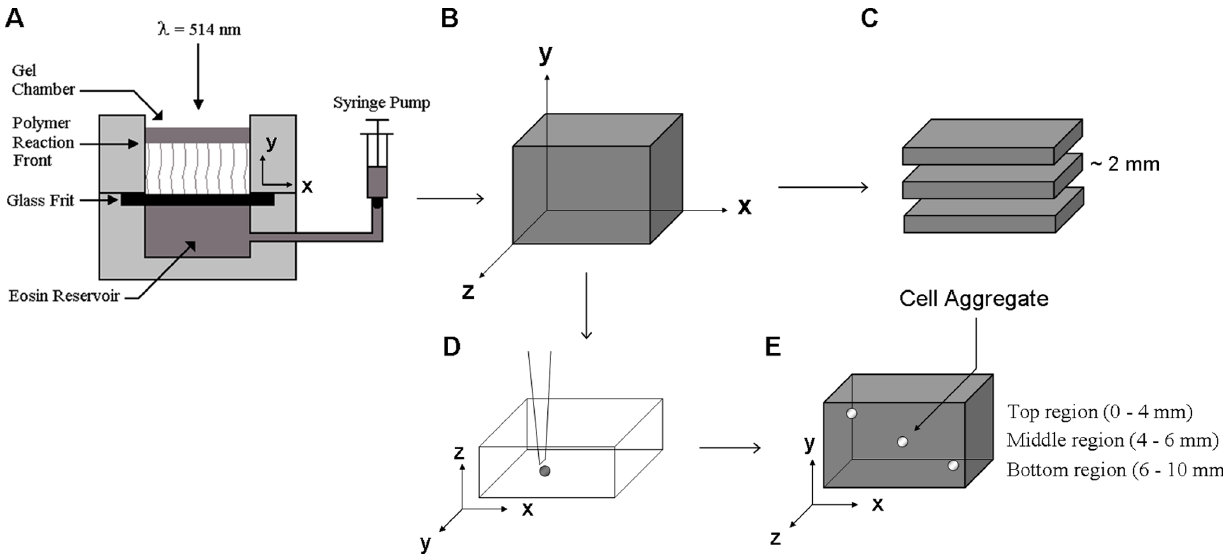
Figure 1. PBFP hydrogel generation and gradient evaluation. (A) Schematic of glass frit perfusion chamber and (B) resultant hydrogel. (C) Hydrogel sectioning for gradient evaluation as well as (D) aggregate seeding in hydrogels (note: hydrogels were rotated 90 u to facilitate aggregate placement in the z-direction) and (E) aggregate location by region. In all cases, the gradient runs in the y-direction with the top of the gel taken as the staring point for gradient characterization. the x-y plane running in the horizontal direction so that the aggregates could be positioned in different regions of the gradient (running in the y-direction). Aggregates were gently placed inside the gels using a micropipette tip (Figure 1D) with aggregate injection performed along the z-axis. Aggregates were situated in the upper (0–4 mm from top), middle (4–6 mm from top), and (Figure 1E) to evaluate the effects of different gradient properties on cell invasion. Aggregates were also seeded within the middle region of bulk polymerized control gels with homogeneously distributed properties. Eight aggregates per region per gel type were seeded with a maximum of two aggregates per region spaced at least 8 mm apart (n= 4 gels/type). Aggregates were imaged along their central axis weekly for three weeks using an Axiovert 200 inverted microscope (Carl Zeiss Inc.) with cell culture media (EGM) changed every other day. Phase contrast images were used to quantify aggregate invasion over time in terms of projected aggregate area (Figure 2A), the aggregate diameter in the direction perpendicular (x-direction) and parallel (y-direction) to the gradient, the anisotropy index ( D y/ D x; Figure 2B), and sprout length by angle (Figure 2C) using Axiovision 4.2 image analysis